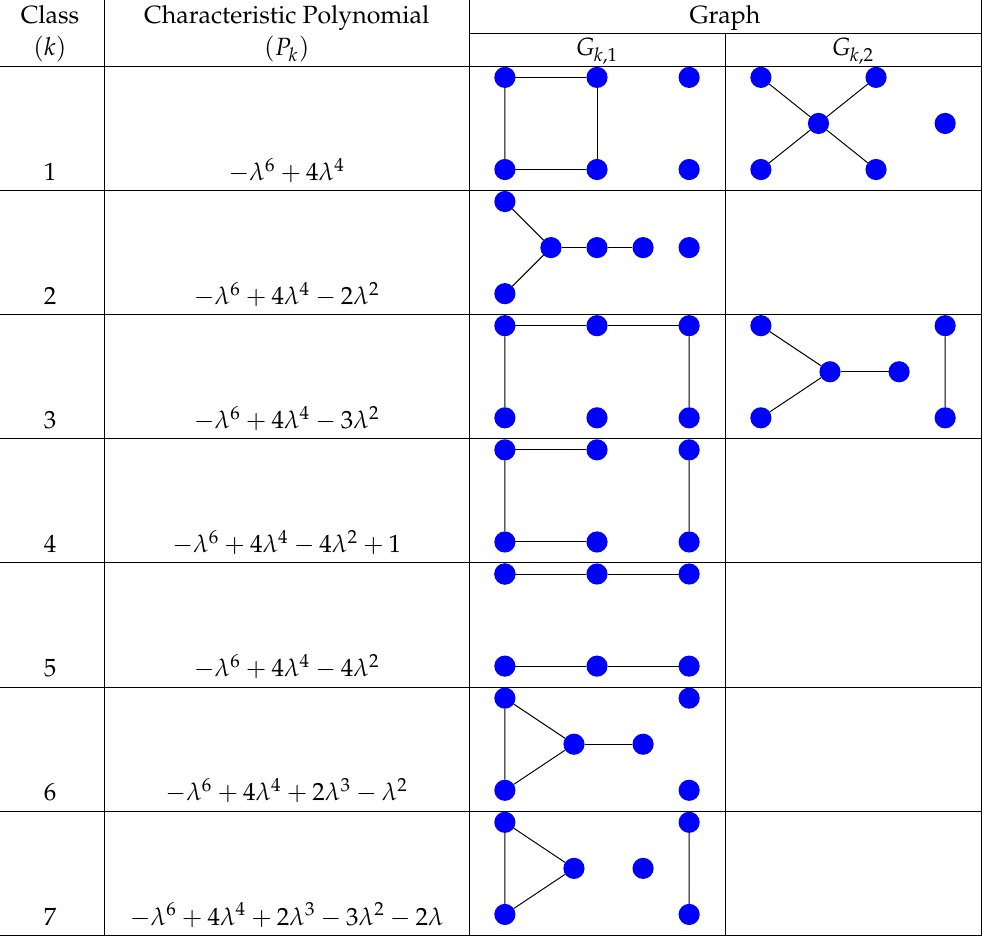
Table A4. All classes of cospectral graphs with six vertices and four